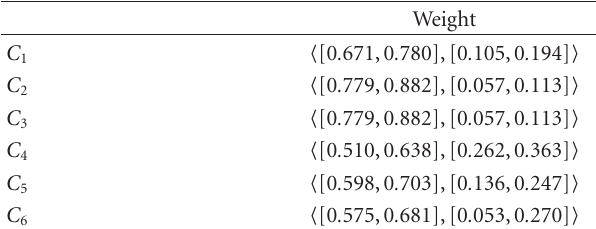
Table 12: Weights of